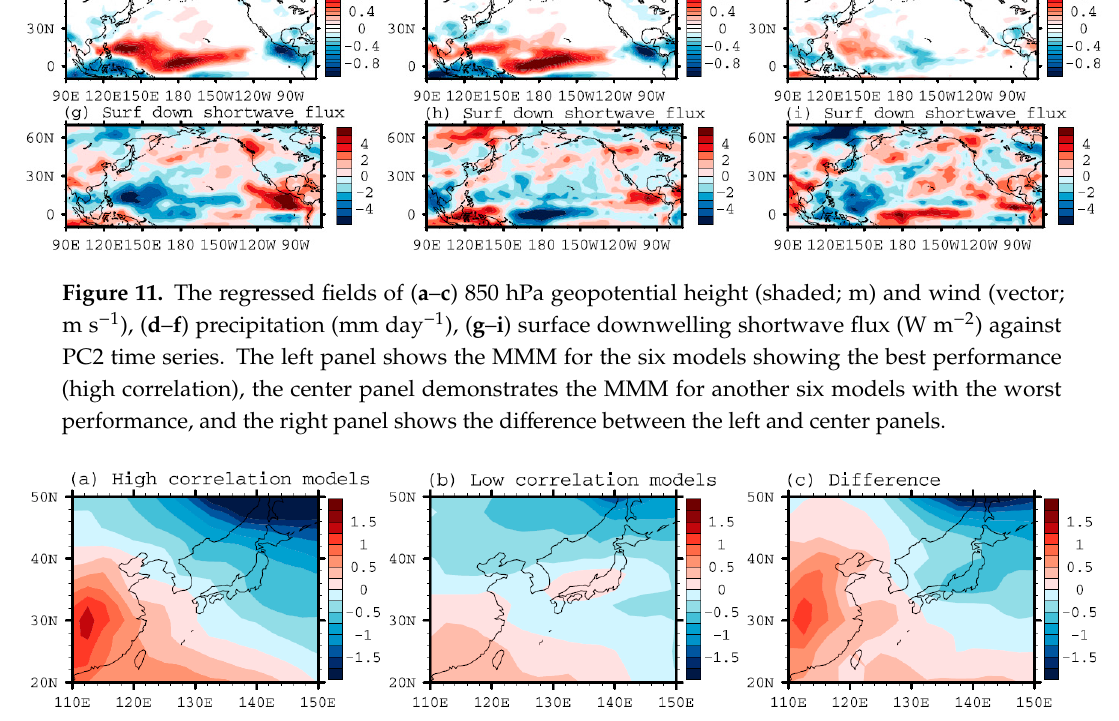
Figure 12. Same as Figure 11, except for the regressed JJA 850 hPa ozone.